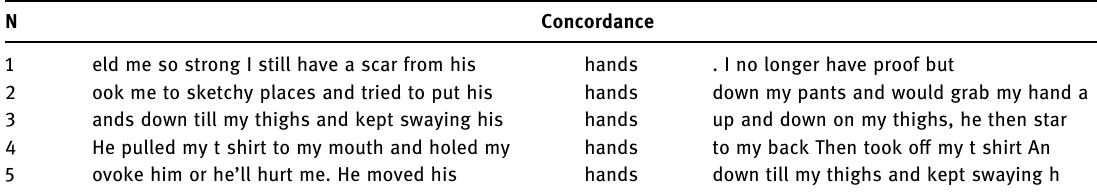
Table 47: Concordance lines for hands